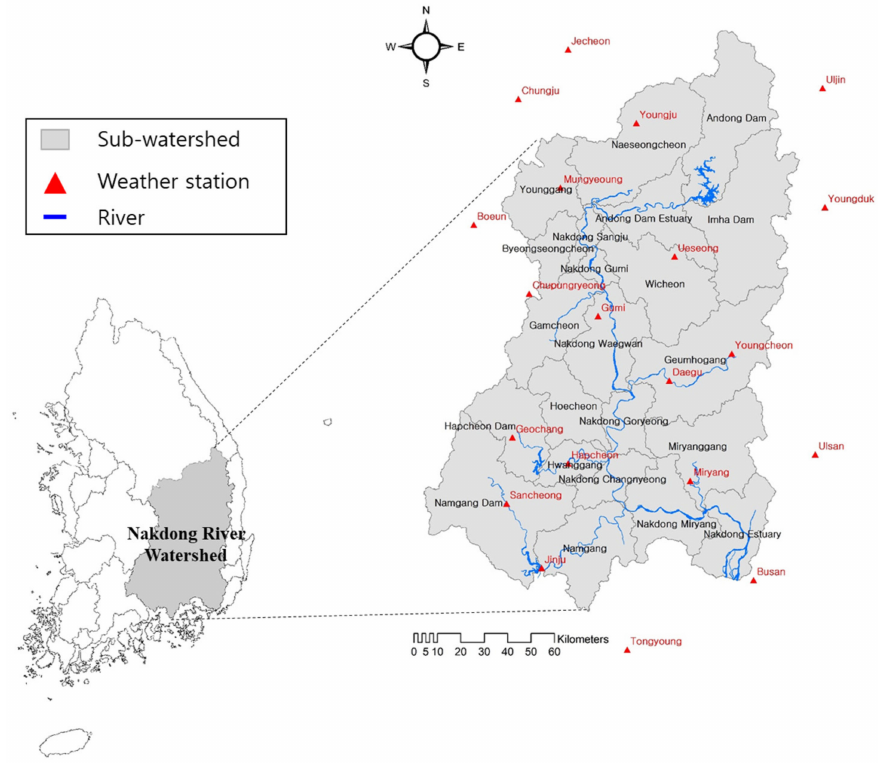
Figure 1. Study area (Nakdong